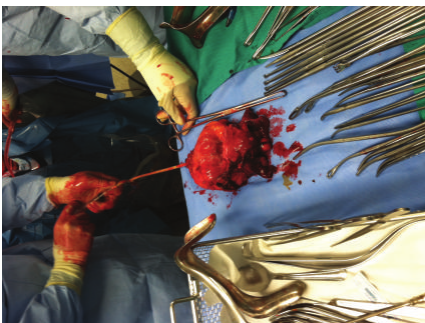
Figure 2: The surgical specimen removed transvaginally included the bladder, uterus, cervix, bilateral ovaries, fallopian tubes, and urethra as well as the anterior